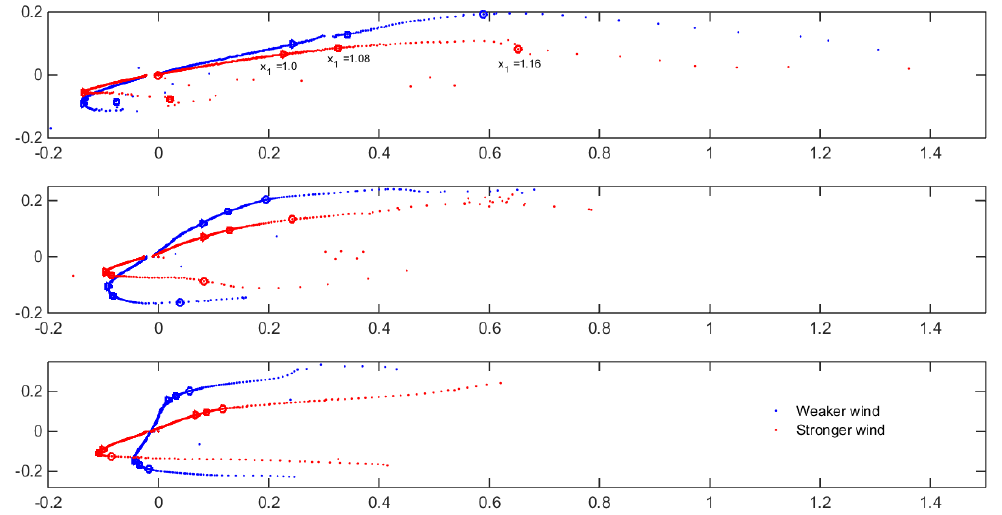
Figure 9. Velocity ( u 2 [m/s)) structures of the drift current during a wave period at x 1 = 3 [m] ( top panel ), x 1 = 5 [m] ( middle panel ), x 1 = 7 [m] ( bottom panel ) at time t = 5 [s] for the case with wind body force f = 0.5 [N/M] (blue labeled as “Weaker wind”) and the case with the wind body force f = 0.6 [N/M] (red labeled as “Stronger wind”). All the circle points in plots correspond to the points with wall-normal x 2 = 1.16 [m], rectangle points correspond to the points with wall-normal x 2 = 1.08 [m] and triangle points correspond to the points with wall-normal x 2 = 1.0